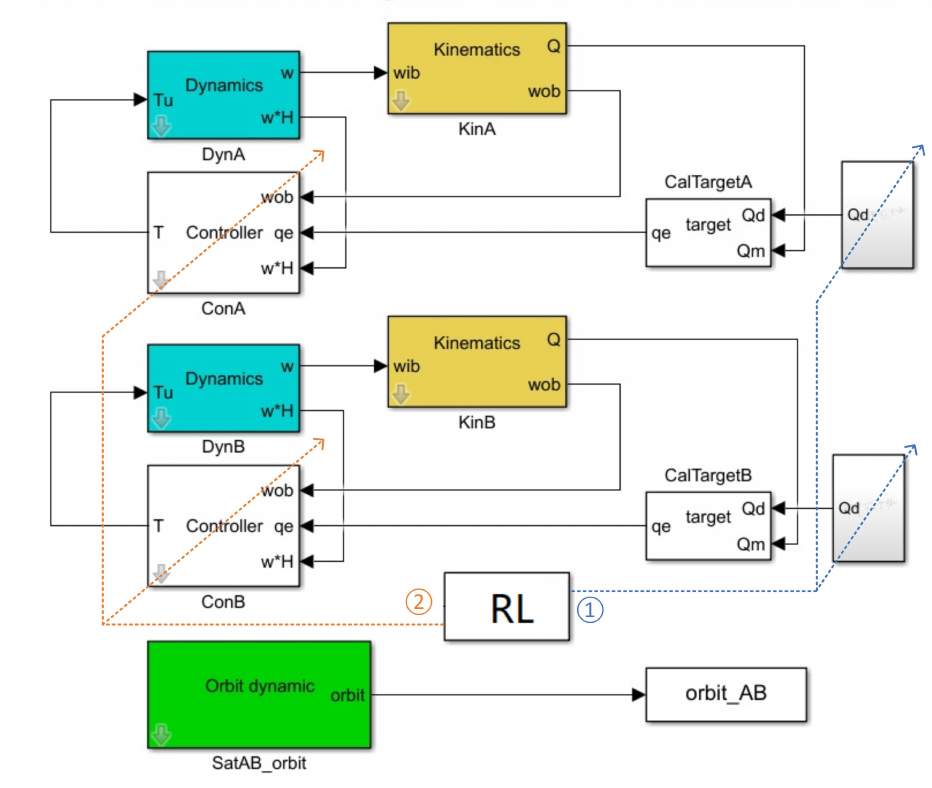
Figure 5. SIMULINK block diagram for APC calibration